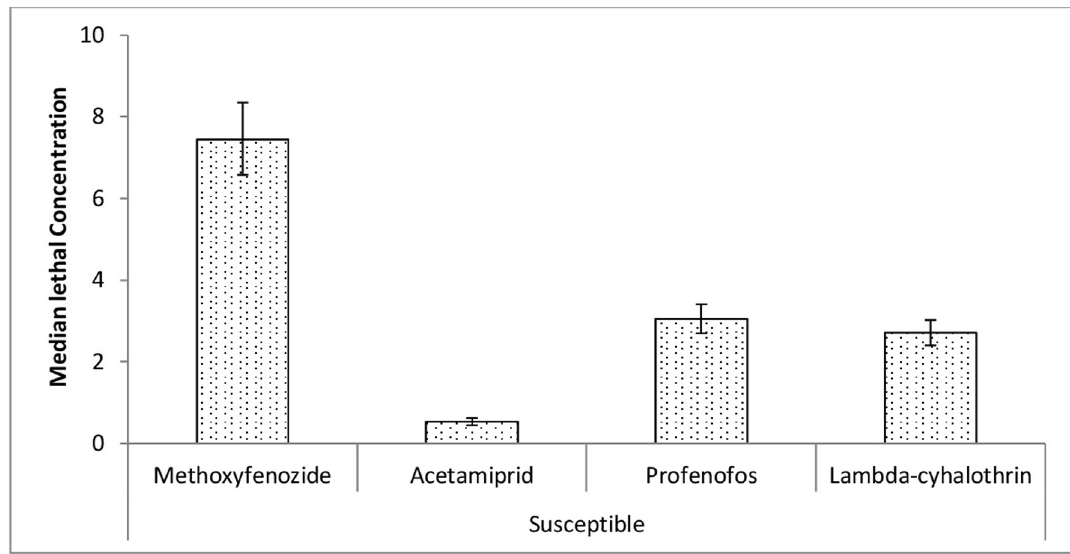
Fig 1. Toxicity of various insecticides to susceptible strain of Chrysoperla carnea . Error Bars show fiducial limits (FLs) of LC 50 s.